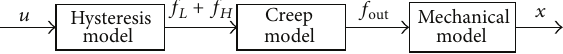
Figure 3: Block diagram of the modified comprehensive model for